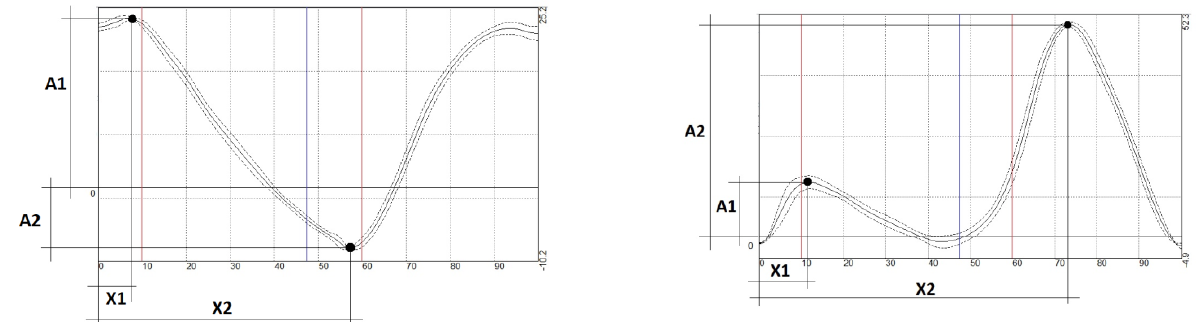
Figure 1. Measured amplitudes (A) and phases (X) in hip ( left graph ) and knee ( right graph ) goniograms are shown in the average graphs.